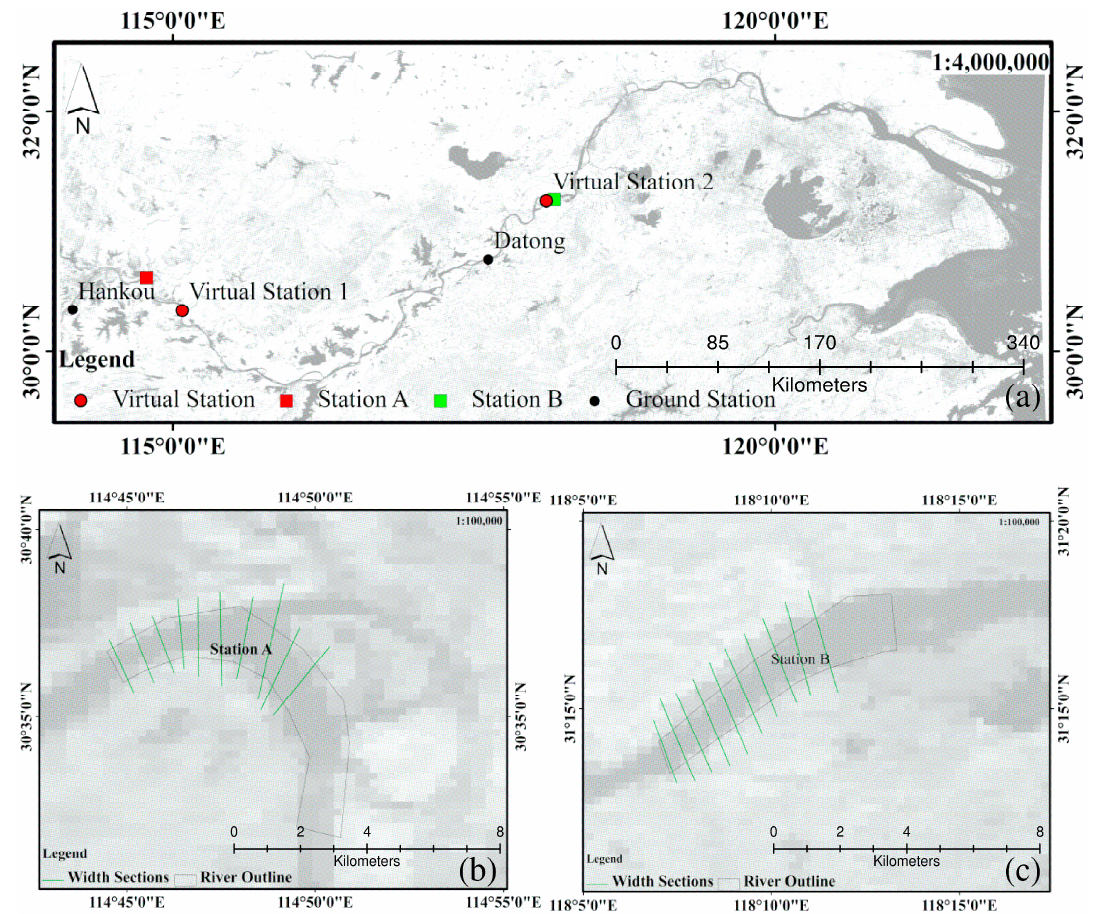
Figure 5. An illustration of the study area. The background image is a MODIS (MOD09GQ) band 2 overlaid by Envisat altimetry virtual stations 1 and 2 ( a ), insets of Figure 5a showing sections for river width measurements at an upstream station A ( b ), and a downstream station B ( c ).